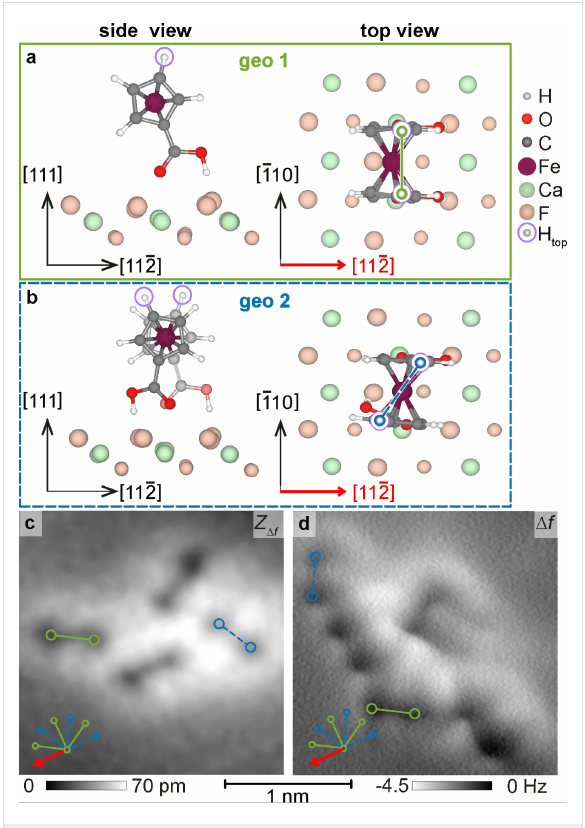
Figure 1: Dumbbell shape of single FDCA molecules. Quadruped binding motif of FDCA on CaF 2 (111) (adapted from [22]) of (a) geo 1 and (b) geo 2. Dumbbell shape of FDCA molecules (c) on bulk CaF 2 (111) measured by NC-AFM in topography mode and (d) on thin film CaF 2 (111) surface measured in the constant-height mode (adapted from [22]). The orientations of the two geometries geo 1 and geo 2 are marked by solid green and dashed blue lines, respectively, and are included in all images with the respective orientation. (A five pixel averaging filter was applied to reduce noise within the frequency shift image. An inverted colour scale is used for the constant-height Δ f NC-AFM data to match the topography